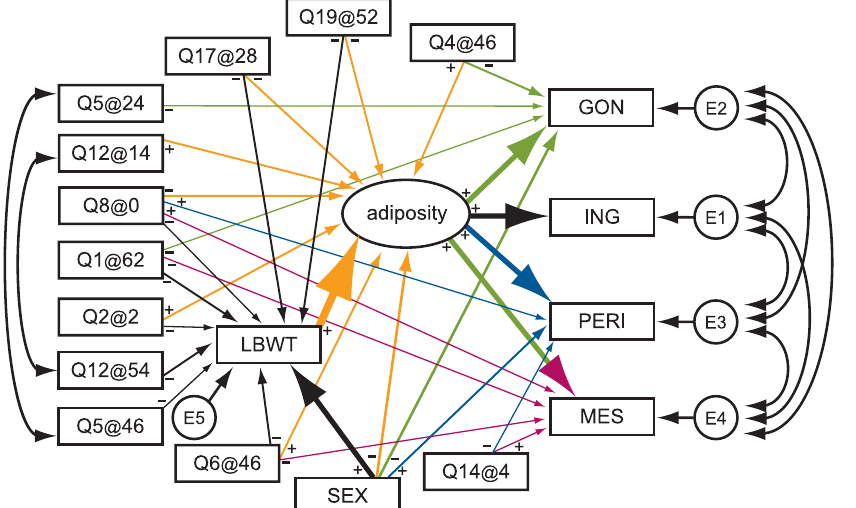
Figure 6. Structural Equation Model for Adiposity and Lean Body weight The four fat pad traits are gonadal (GON); inguinal (ING); mesenteric (MES); and peritoneal (PERI). Single-headed arrows indicate causal paths, and the thickness of each arrow is proportional to the effect sizes. Doubled-headed arrows denote unresolved covariance. The boxes indicate measured traits or QTL and the oval denotes a latent variable. E1, E2, E3, E4, and E5 denote unobserved residual error. The negative sign from a QTL to a trait indicates that the NZB allele is associated with high trait values. DOI: